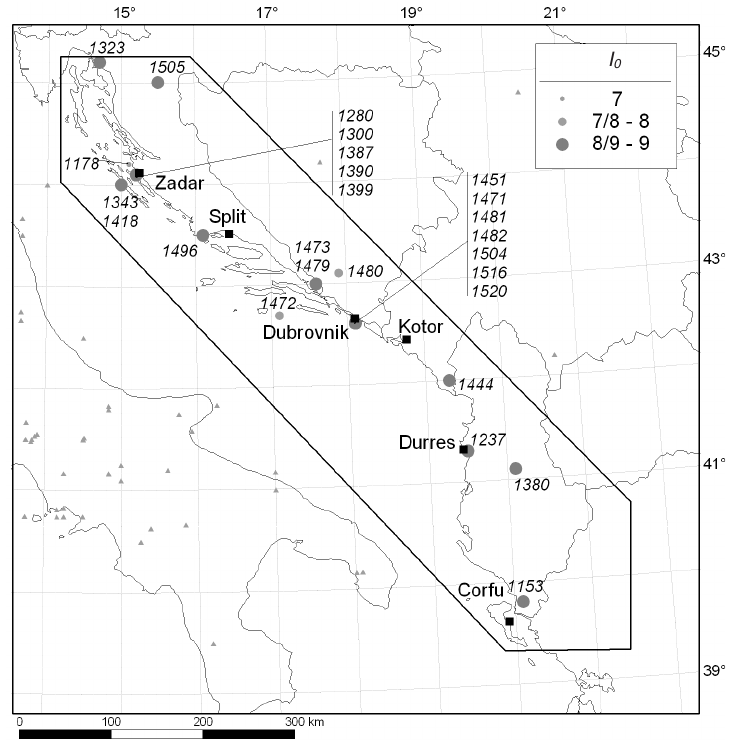
Fig. 6. Seismicity in Eastern Adriatic between 1000 and 1529 according to parametric earthquake catalogues. Earthquakes here considered are those from 1300 to